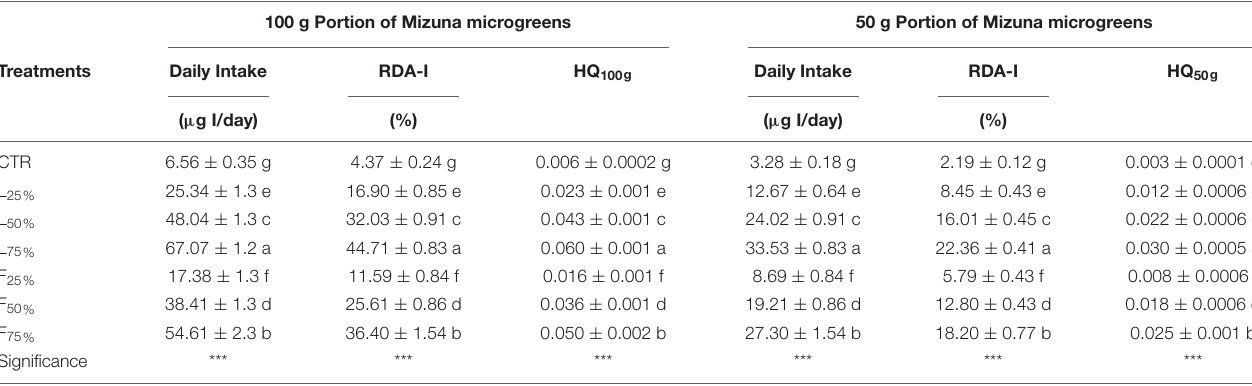
TABLE 5 | Daily intake, percentage of recommended daily allowance for I (RDA-I) and hazard quotient (HQ) for intake of I through consumption of 50 and 100 g portions of Mizuna microgreens, produced in indoor condition, by adult humans (70 kg body weight). 100 g Portion of Mizuna microgreens 50 g Portion of Mizuna